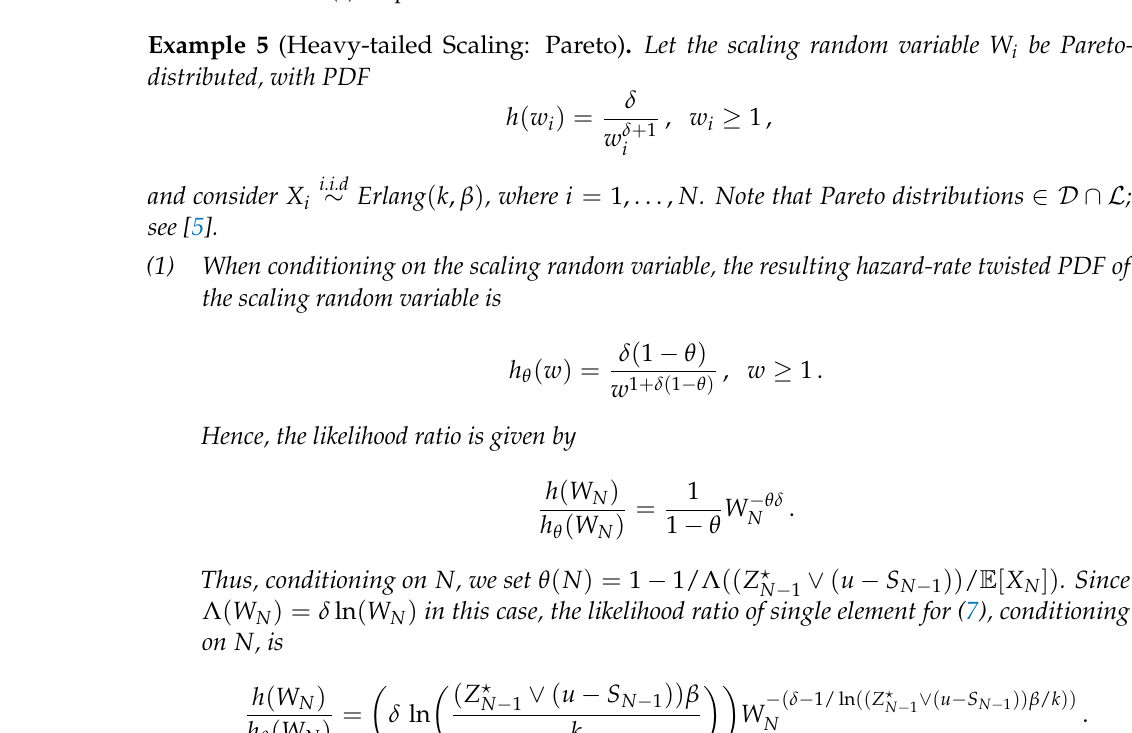
Figure 5. The number of summands N = 30, W i i.i.d ∼ Weibull ( 0.35,2 ) , X i i.i.d ∼ Erlang ( 2,3 ) , where i = 1, . . . , N . Black squares: ConAK1+IS+CV (conditioning and IS on Weibull). Red stars: ConAK2+CV (conditioning on Erlang). Blue dots: ConAK2+IS+CV (conditioning and IS on Erlang using an exponential PDF). Cyan diamonds: ConAK2+IS+CV (conditioning and IS on Erlang using an Erlang PDF). ( a ) Estimates of (cid:96) ( u ) as a function of u on a logarithmic scale. ( b ) Empirical logarithmic rates as a function of u . ( c ) Empirical relative errors as a function of u